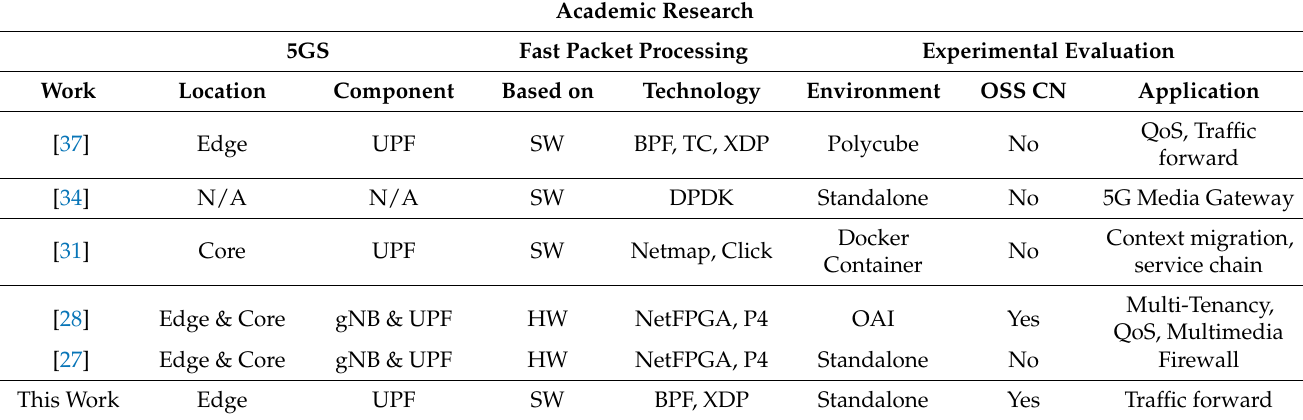
Table 3. Related work. Legend: U/D-Under Development; N/A-Not Apply; All-All NCG compo- nents;